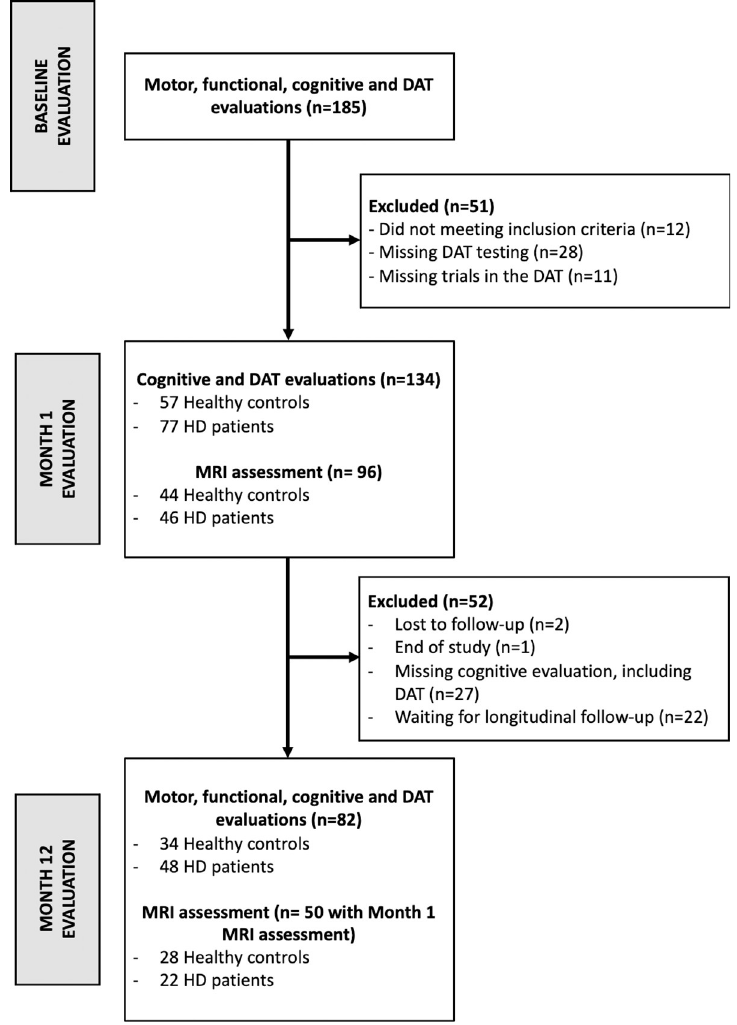
Fig 1. Repair-HD study participant disposition in this current study. DAT Digitalized Arithmetic Task, HD Huntington